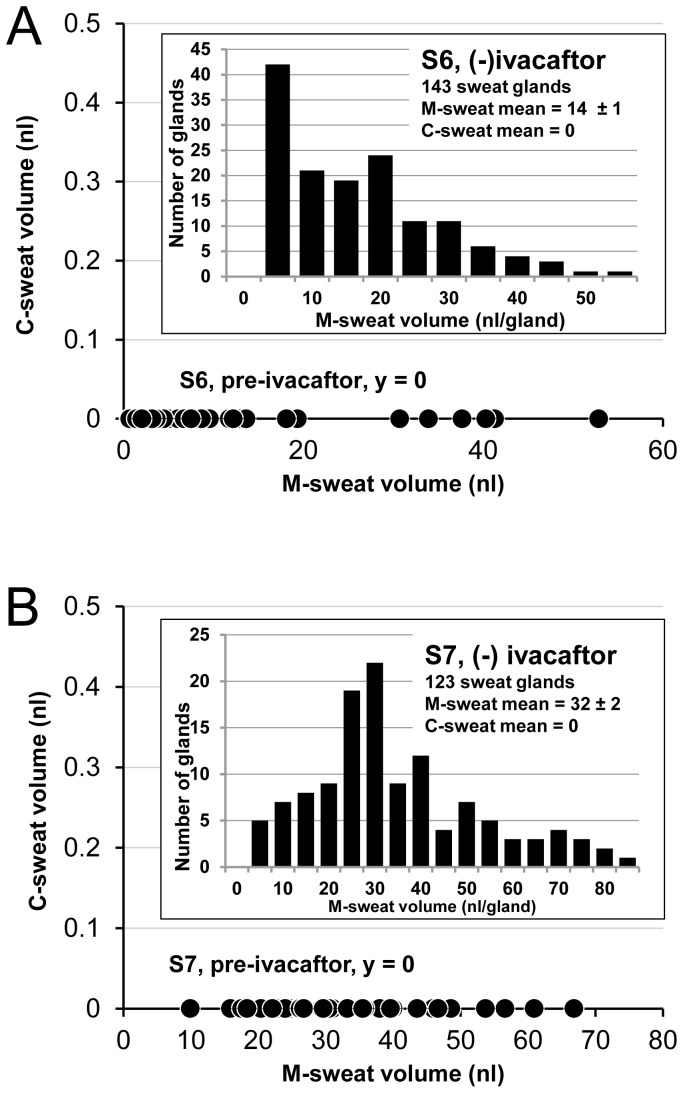
Absence of C-sweat secretion (−) ivacaftor in two G551D CF subjects.(A) S6: female, F508del/G551D. Each symbol in the main graph shows M-sweat volumes produced by a single sweat gland (x-axis) and C-sweat (truncated y axis, all C-sweat values were zero). The distribution of M-sweat volumes is shown in the inset. (B) S7: female, F508del/G551D. Same format as for S6.